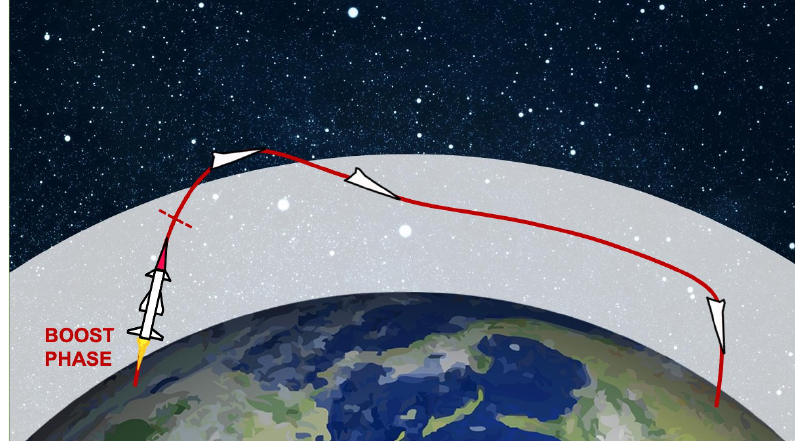
Figure 4. The trajectory of a Hypersonic Glide Vehicle (HGV). The red dashed line represents the boundary of the boost phase. The white area represents the